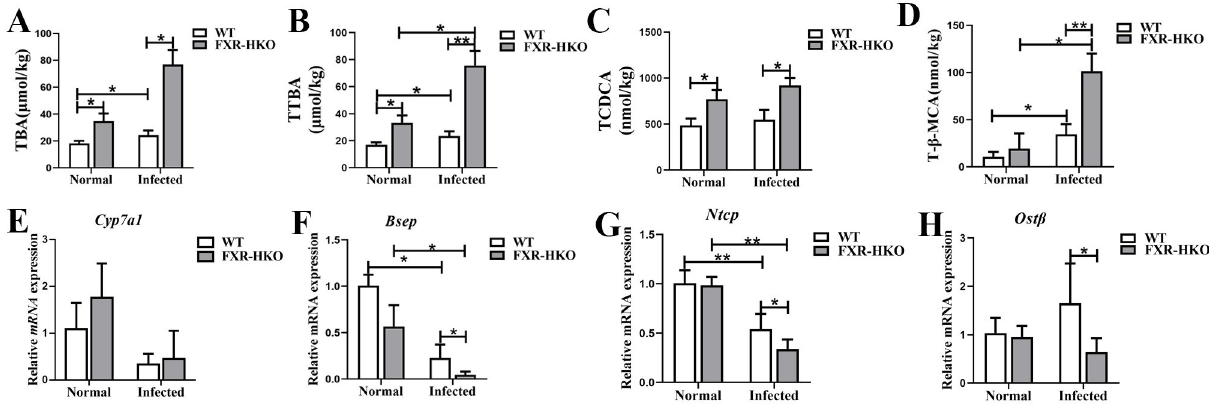
Fig 5. Bile acid homeostasis is disrupted in FXR-deficient mice with S . japonicum infection. The content of TBA (A), TTBA (B), TCDCA (C), and T- β -MCA (D) in mice liver from each group. The hepatic mRNA levels of Cyp7a1 (E), Bsep (F), Ntcp (G), and Ost β (H) in each group were detected by RT-qPCR. Data are expressed as mean ± SEM. � P < 0.05, �� P < 0.01.